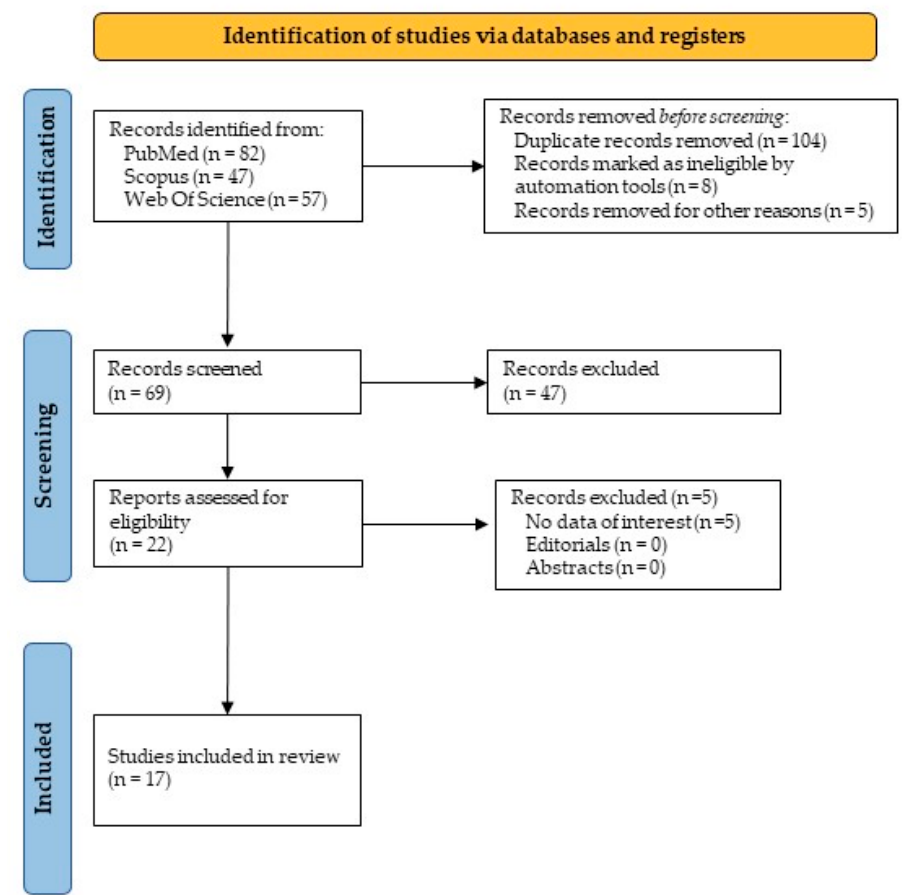
Figure 5. PRISMA flowchart and literature results.